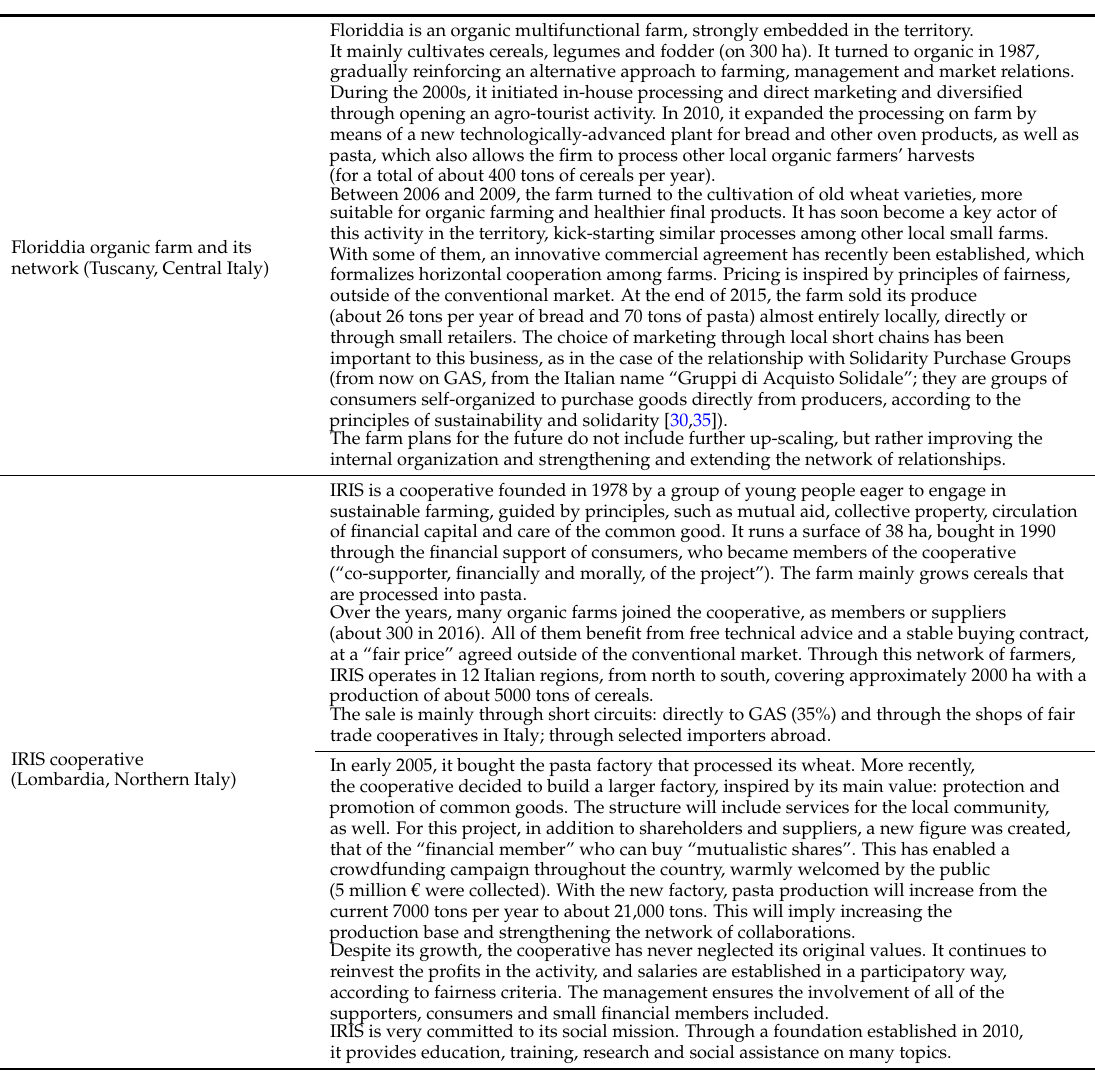
Table 1. The studied